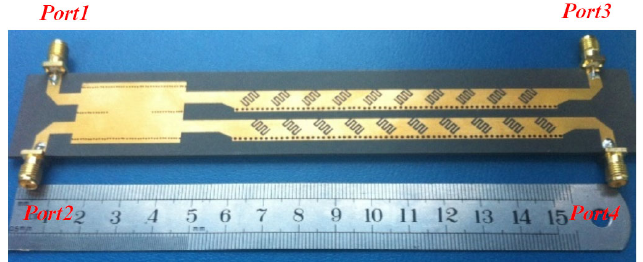
Figure 14. Photograph of the fabricated